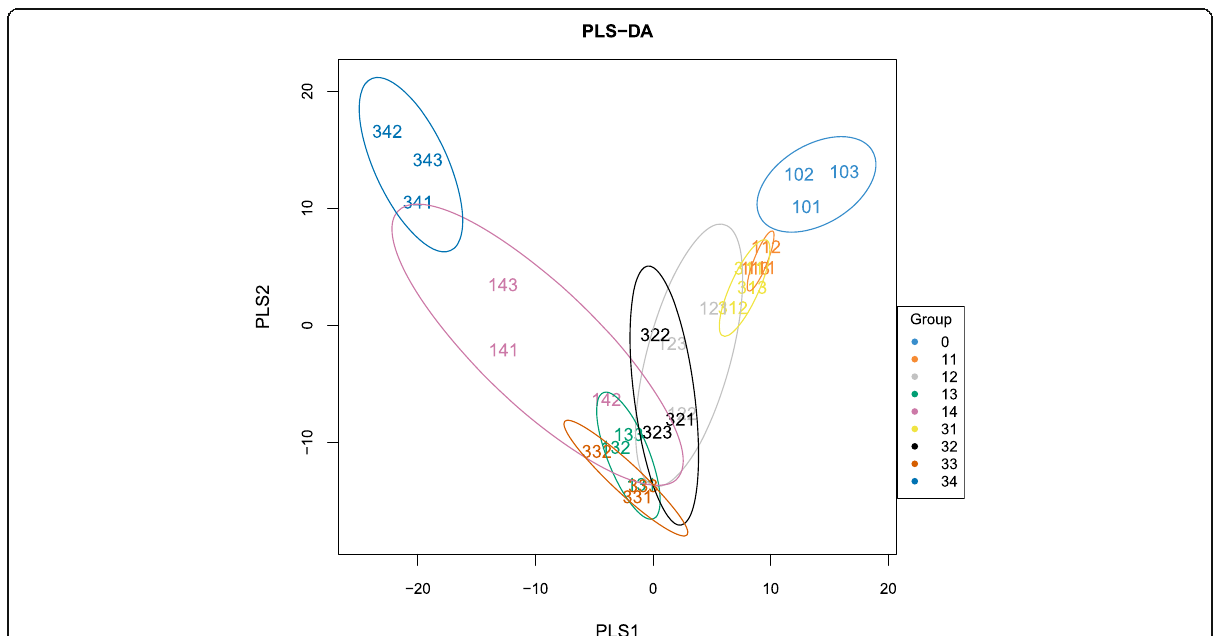
Fig. 3 Characteristics of soil colony in rhizosphere of maize in different growth stages. Samples marked with three numbers: 101, 102,103 = repeats of soil at the time of planting; 111, 112, 113 = rhizosphere soil at the three-leaf stage of control; 121, 122, 123 = rhizosphere soil at the jointing stage of control; 131, 132, 133 = rhizosphere soil at the tasseling stage of control; 141, 142, 143 = rhizosphere soil at the maturity stage of control; 311, 312, 313 = rhizosphere soil at the three-leaf stage of inoculation (P8/P10/X52) treatment; 321, 322, 323 = rhizosphere soil at the jointing stage of inoculation treatment; 331, 332, 333 = rhizosphere soil at the tasseling stage of inoculation treatment; 341, 342, 343 = rhizosphere soil at the maturity stage of inoculation